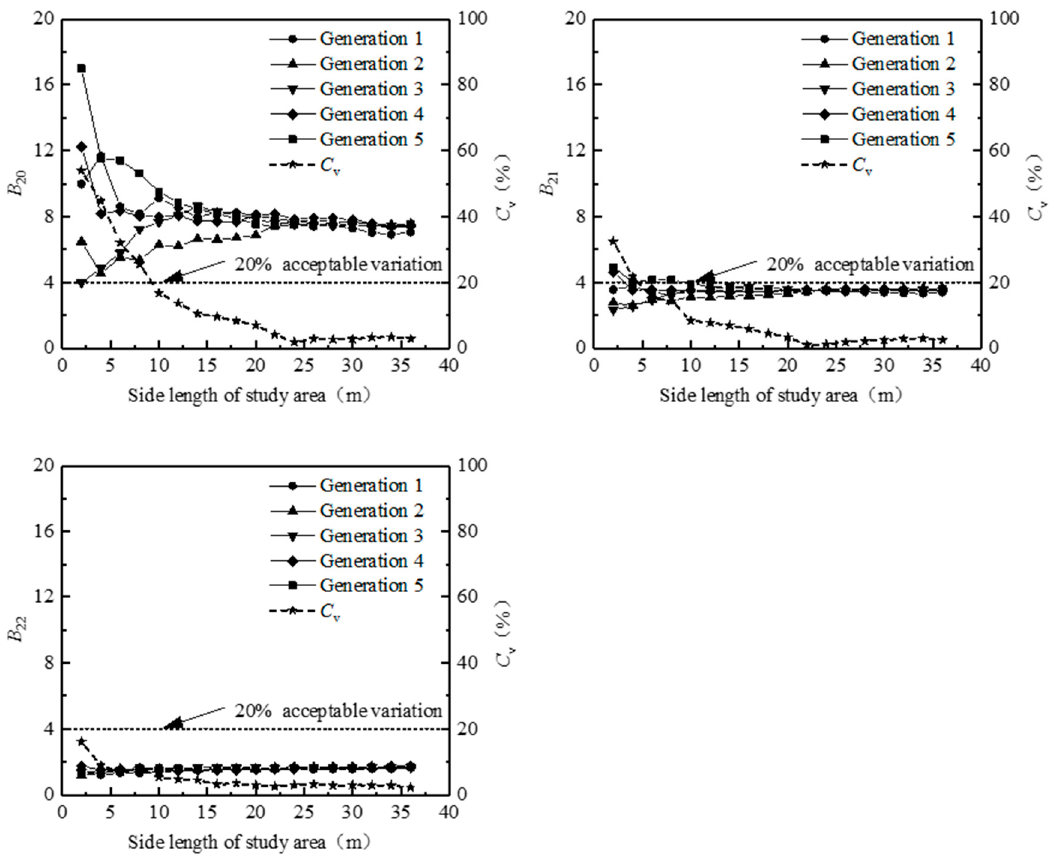
Figure 6. The branch strength ( B 2X ) and the coefficient of variation ( C v ) versus sample size.